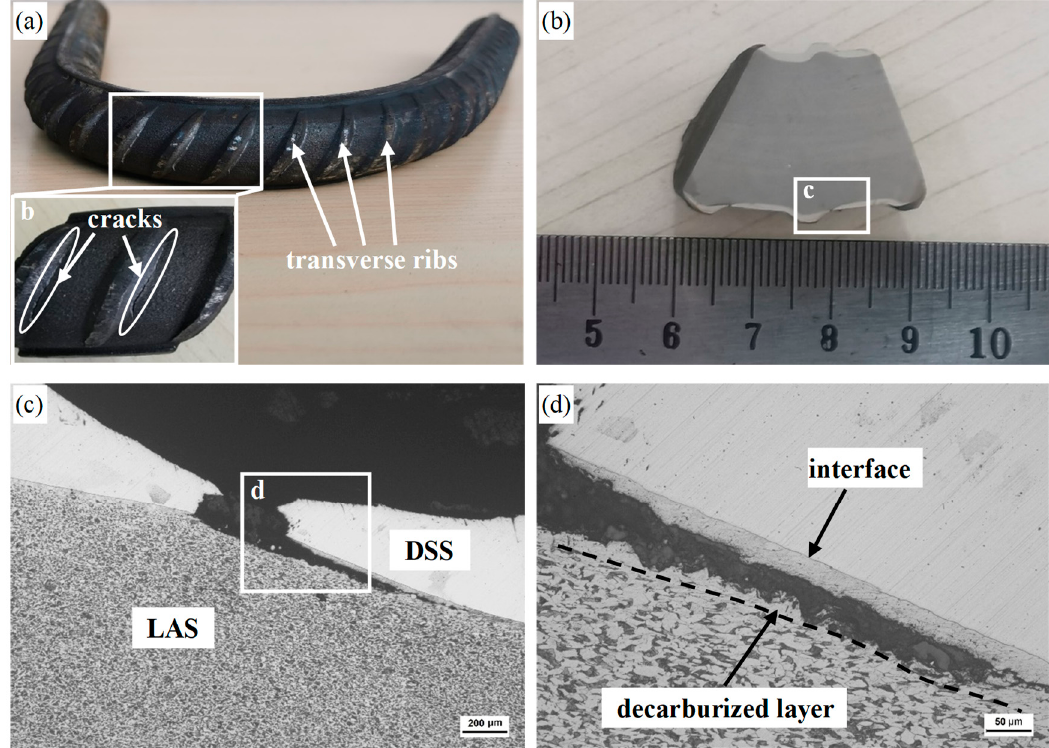
Figure 10. Results of the bending test of the DSS/LAS-clad rebar: ( a ) DSS/LAS-clad rebar after bend- ing, ( b ) longitudinal section of the DSS/LAS-clad rebar after bending, ( c , d ) metallographic diagram of the crack.